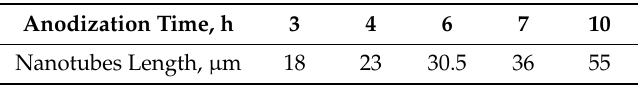
Figure 10. Photoconversion efficiency of modified TNTAs and pristine (unmodified) TNTAs. Table 2. Nanotubes lengths anodized for different anodization times.